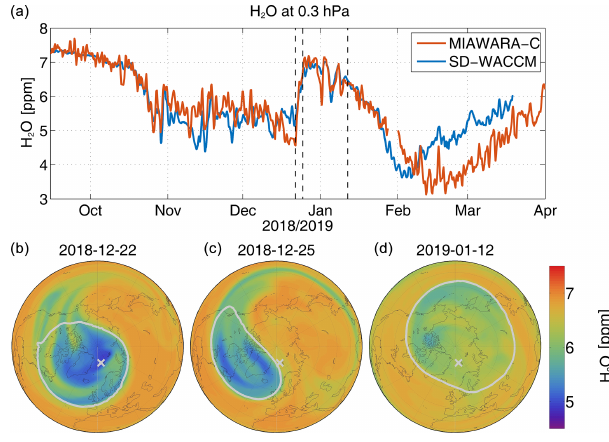
Figure 9. Same as in Fig. 8 but for MIAWARA-C water vapour VMR time series at